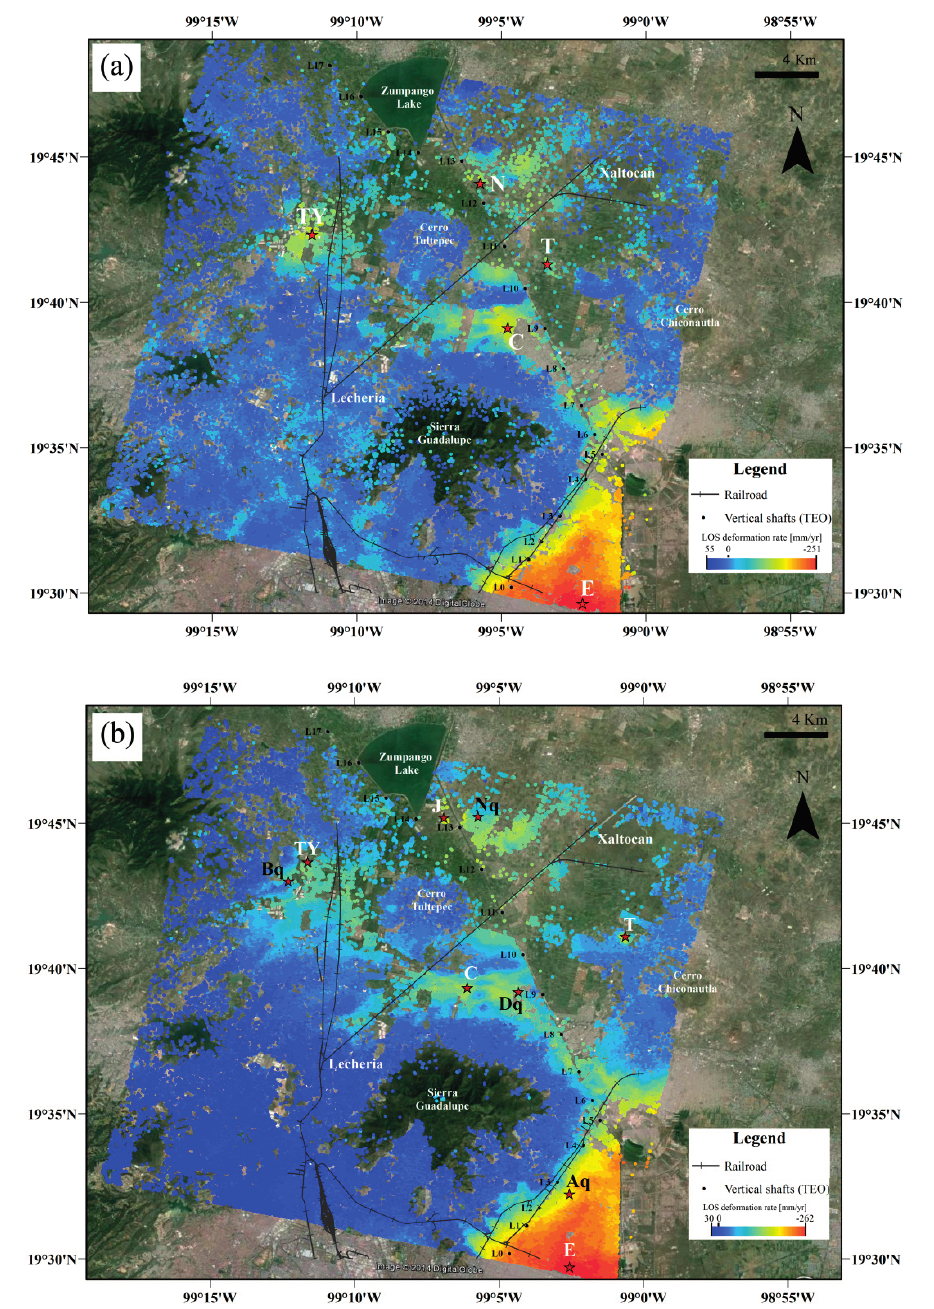
Figure 3. LOS deformation maps. ( a ) ERS; ( b ) ENVISAT. Time series for selected SDFP pixels (red stars) in each map are shown in Figure 4. Examples of time series presenting a non-linear component and corresponding to pixels Aq, Bq, Nq and Dq are presented in Section